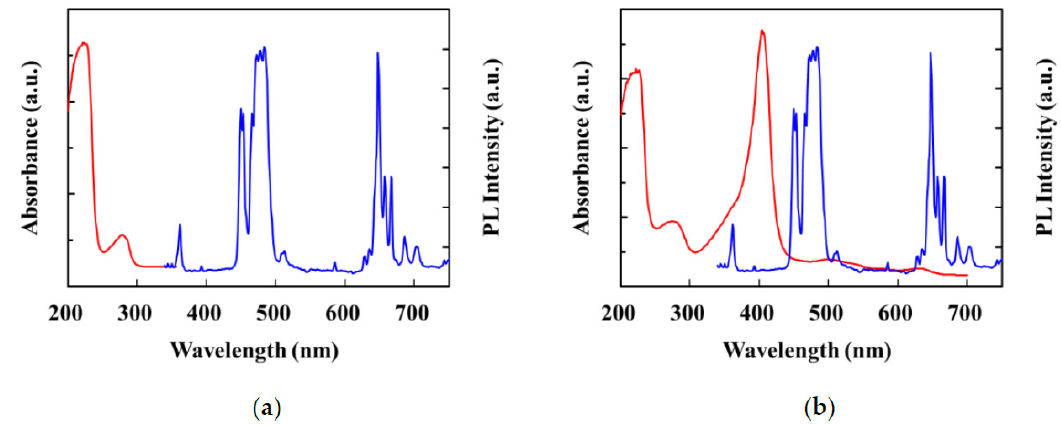
Figure 6. Spectral overlap between the UV–vis absorption spectrum of templates (red line) and the fluorescence spectra of the UCNPs@MIP (blue line). Albumin ( a ) and hemoglobin ( b ) as templates.